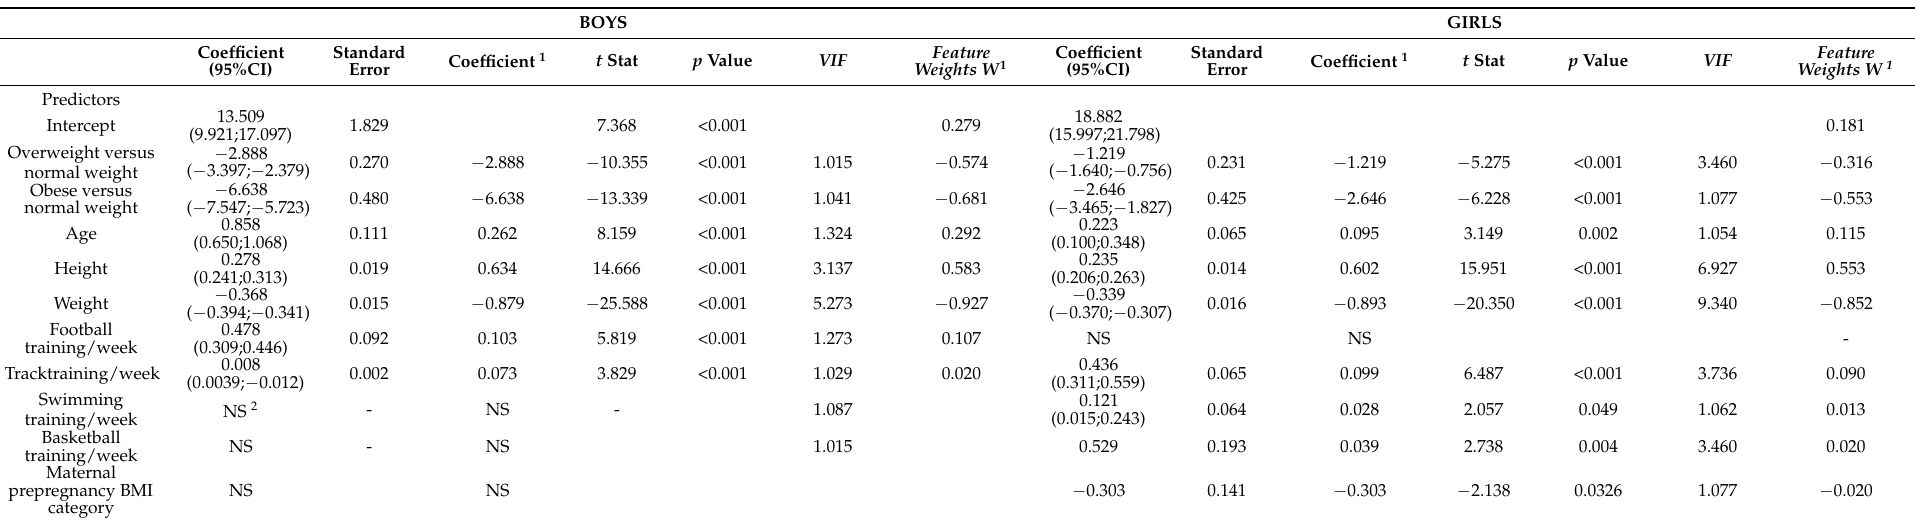
Table 5. MLR results and SVR-linear feature weights by